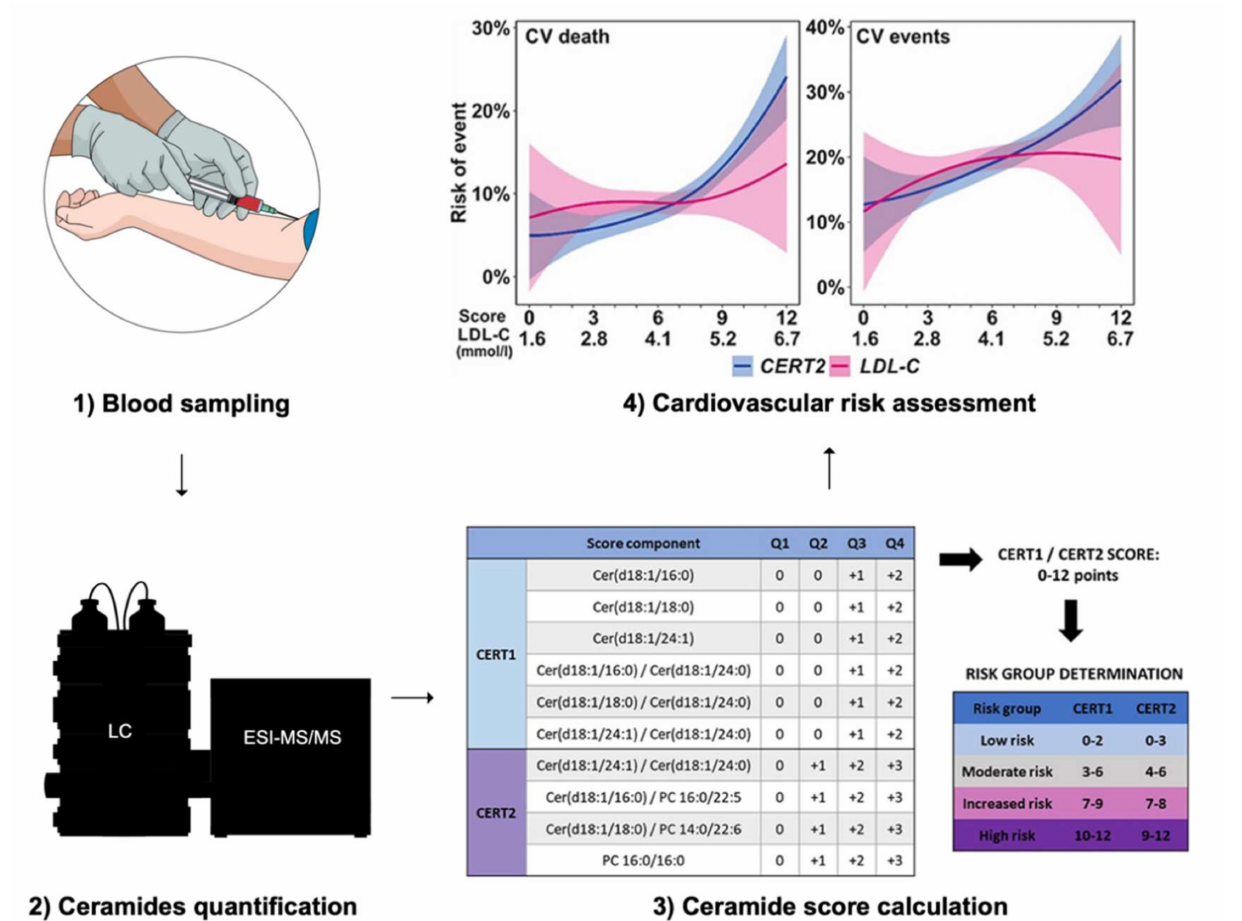
Figure 3. Cardiovascular risk assessment using ceramides-based scores. Abbreviations: LC = liquid chromatography, ESI-MS/MS = electrospray ionization tandem-mass spectrometry, CV = cardiovascular, LDL-C = low-density lipoprotein cholesterol, CERT1 = Ceramide Test Score 1, CERT2 = Ceramide Test Score 2. The figures illustrating the stages 3 and 4 are reproduced, without modification, under the terms of the Creative Commons Attribution License from Hilvo et al.